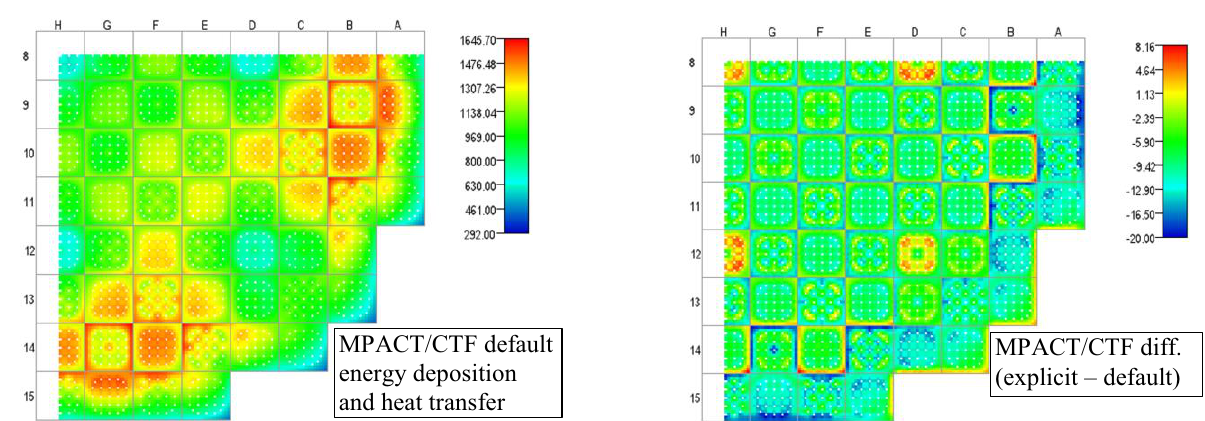
Figure 3. Fuel centerline temperatures of default MPACT/CTF heat transfer (left) and the difference of fuel centerline temperatures of explicit heat transfer (right).